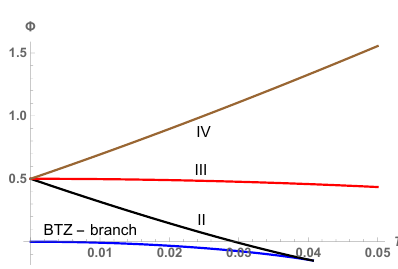
Figure 3 . The grand potential for the four branches of black holes with spin-three chemical potential (cid:22) . Here (cid:22) = 1, T the temperature, and the grand potential is plotted as a function of the dimensionless parameter (cid:22)T